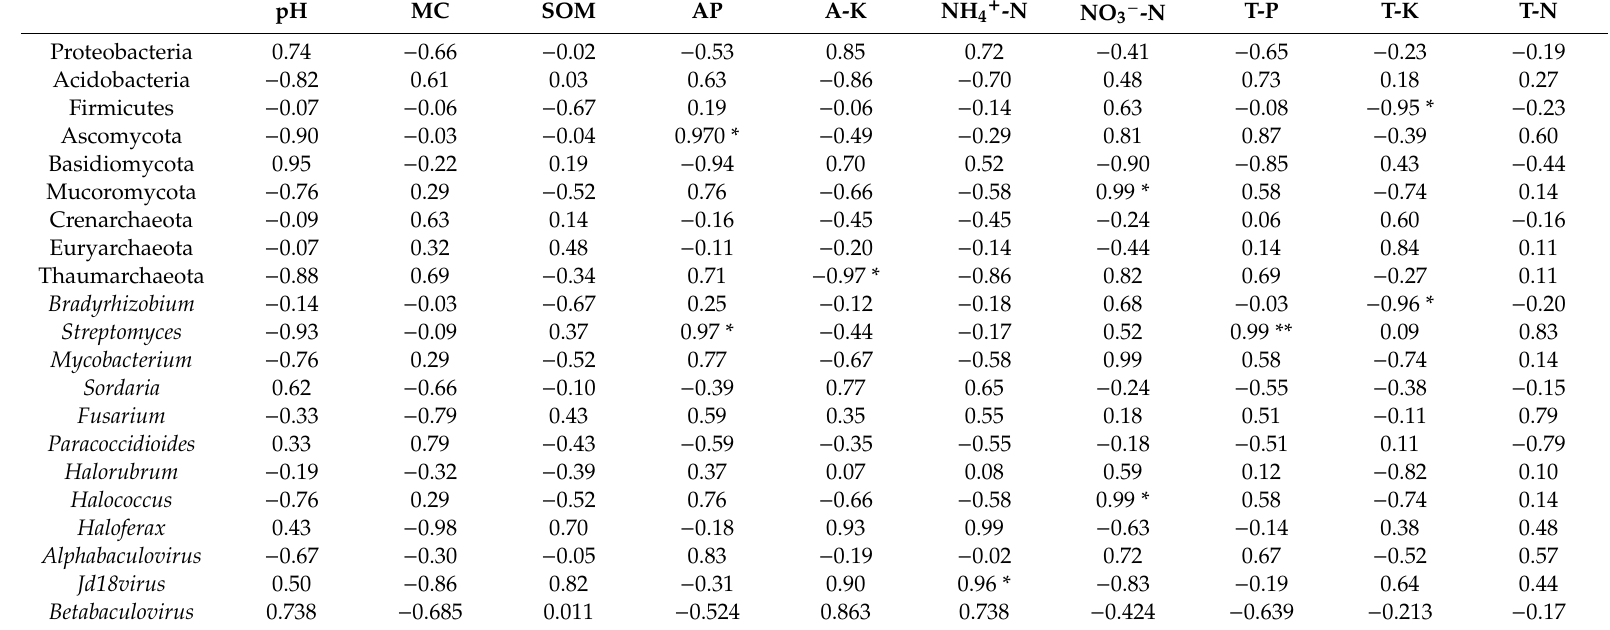
Table A3. The relationship between soil chemistry properties and the dominant